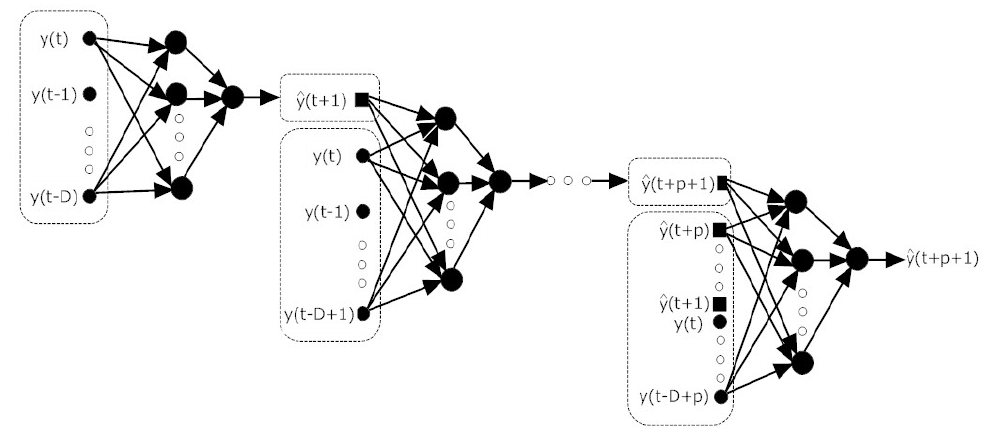
Fig. 2. Unfolding the multi-step